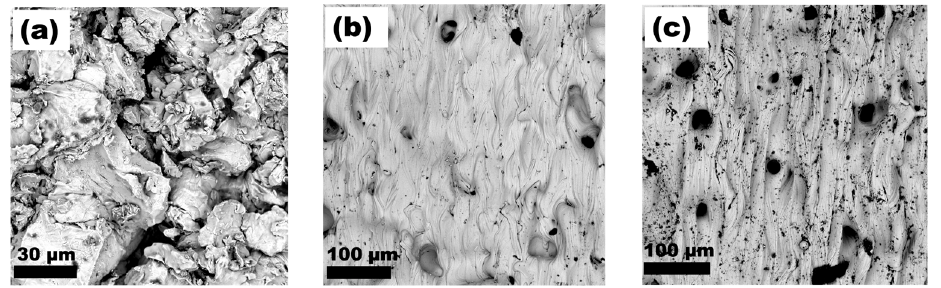
Figure 6. SEM images of surface morphologies ( a ) Ti-0, ( b ) Ti-3, ( c ) Ti-2.